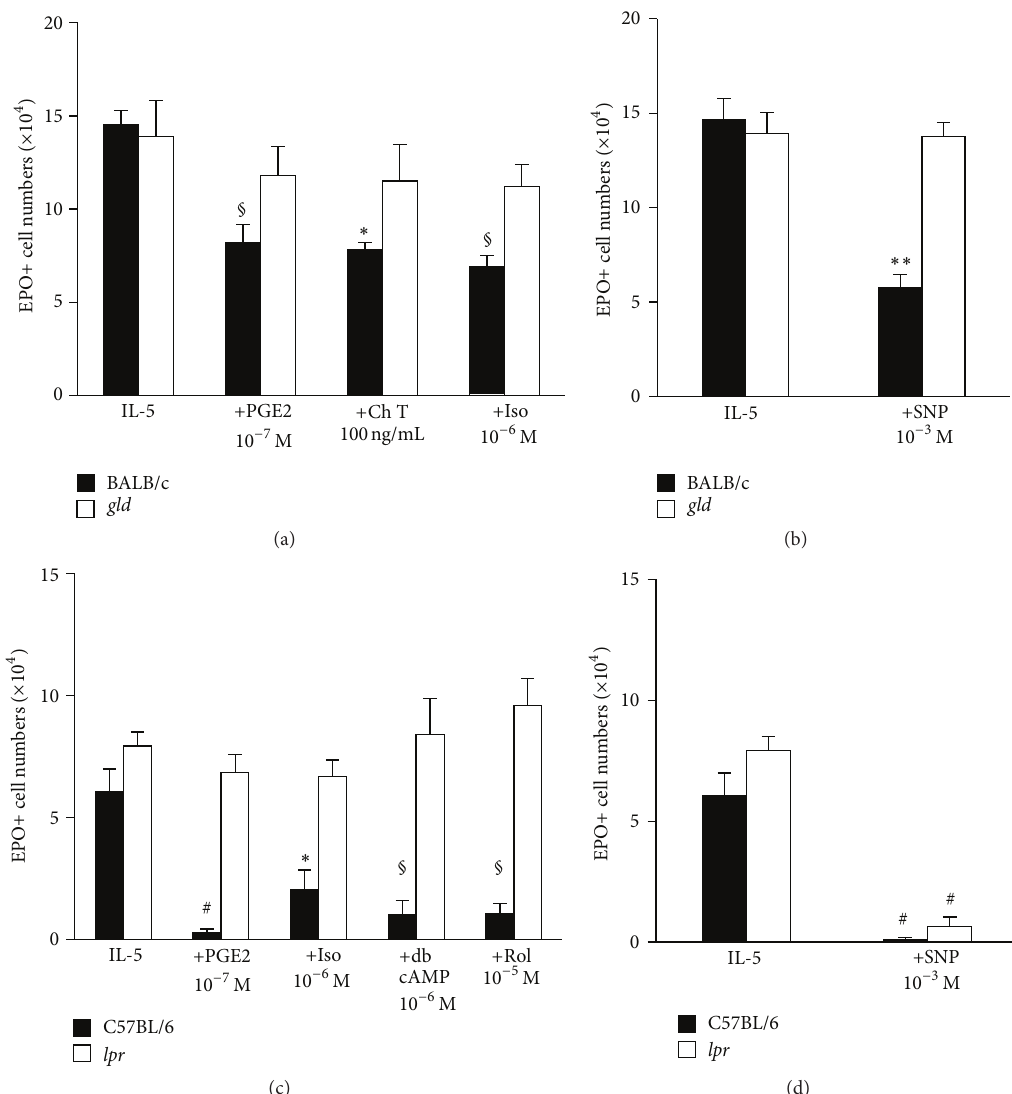
Figure 7: Impact of CD95L and CD95 deficiency in bone-marrow responses to cAMP-dependent agonists and to an NO donor. Bone- marrow cultures were established from BALB/c and mutant gld mice of the same background, lacking CD95L ((a) and (b)) or from C57BL/6 and mutant lpr mice of the same background, lacking CD95 ((c) and (d)), in the presence of IL-5, alone or associated with the indicated concentrations of PGE2, isoproterenol (Iso), cholera toxin (Ch T), Rolipram (Rol), and dibutyryl cAMP (dbcAMP). Where indicated, sodium nitroprusside (SNP), an NO-releasing chemical, was used to evaluate the effectiveness of NO. All agents were present from the beginning of culture for a 7-day period. Data (mean + SEM; 𝑛 = 3 in (c), 𝑛 = 4 remaining panels) are the numbers of EPO+ cells recovered at the end of the culture. Significant differences relative to the respective IL-5 controls: ∗ 𝑃 ≤ 0.05 , ∗∗ 𝑃 ≤ 0.01 , § 𝑃 ≤ 0.005 , # 𝑃 ≤ 0.0025